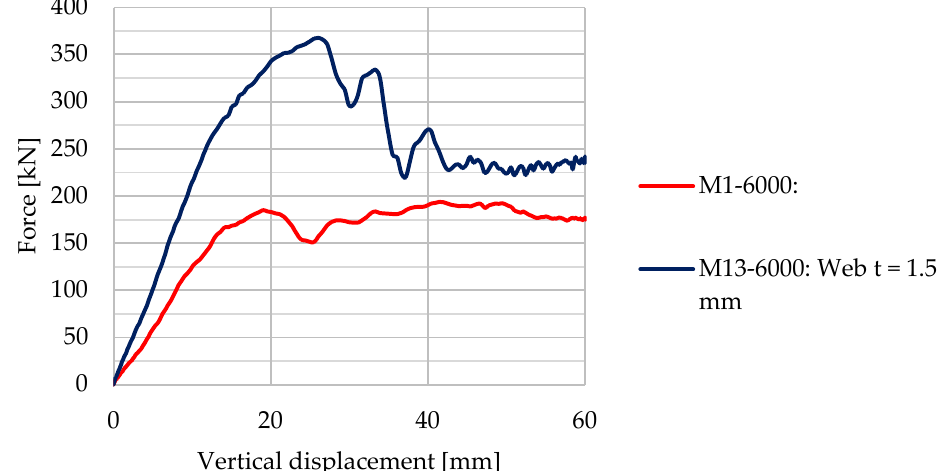
Figure 26. Force–displacement curves for the beam without a web opening, a length of 6000 mm, and corrugated webs with different thickness.